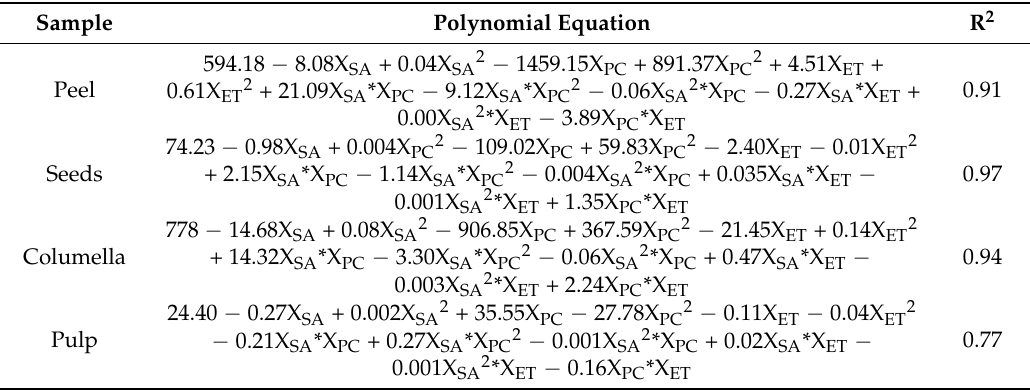
Table 2. The predicted mathematical model for the extraction of soluble polyphenols (mg/g) from Annona muricata peel, seeds, columella, and pulp after ultrasound-assisted extraction.